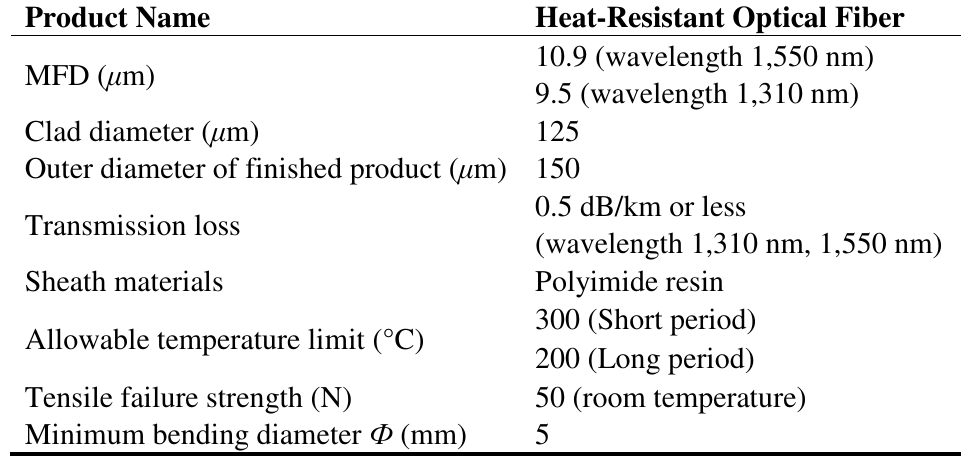
Table 1. Properties of the optical fiber used to fabricate the FOD